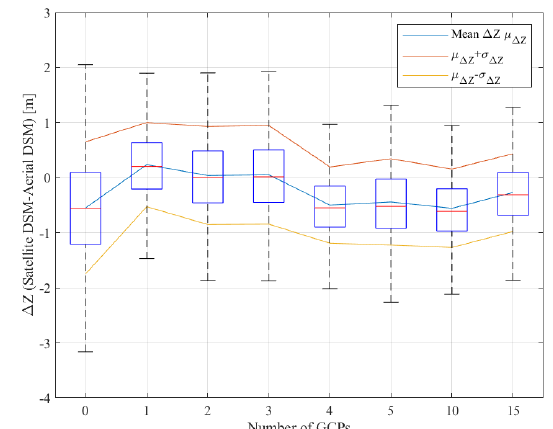
Figure 8 – Orthoimagery (aerial DSM) planimetric accuracy: 2D RMSE (17 CPs) for each configuration of GCPs